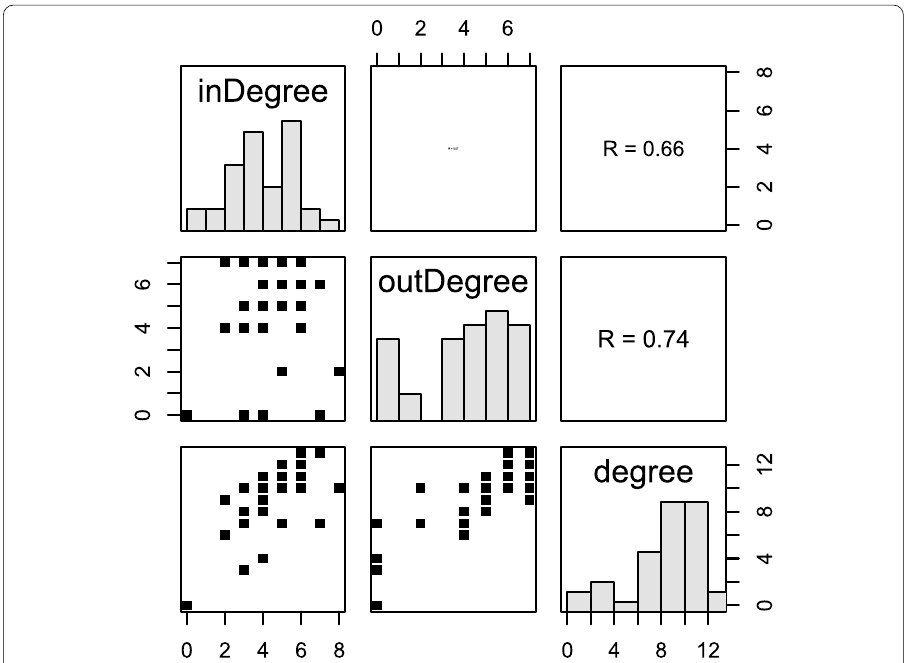
Fig. 14 Degree centrality distributions, scatterplots, and Spearman correlation coefficients for Spring 2016 exam 1